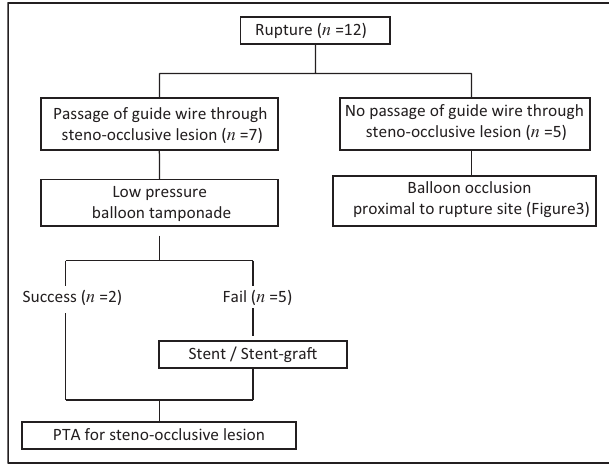
FIGURE 2: Flowchart of the management of central vein rupture while performing percutaneous transluminal angioplasty.